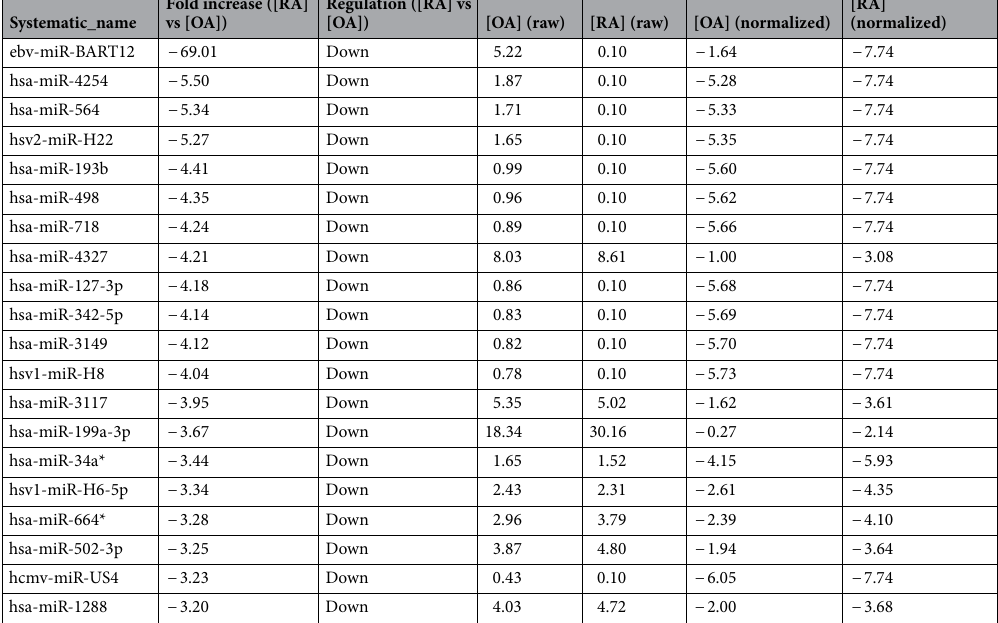
Table 1. List of genes whose expression levels of miRNAs were significantly more than three times higher in MCs from OA patients than in MCs from RA patients. Raw data from miRNA microarrays, normalized normalized data obtained from miRNA microarrays (please see “Materials and methods” section), MCs mast cells, OA osteoarthritis, RA rheumatoid